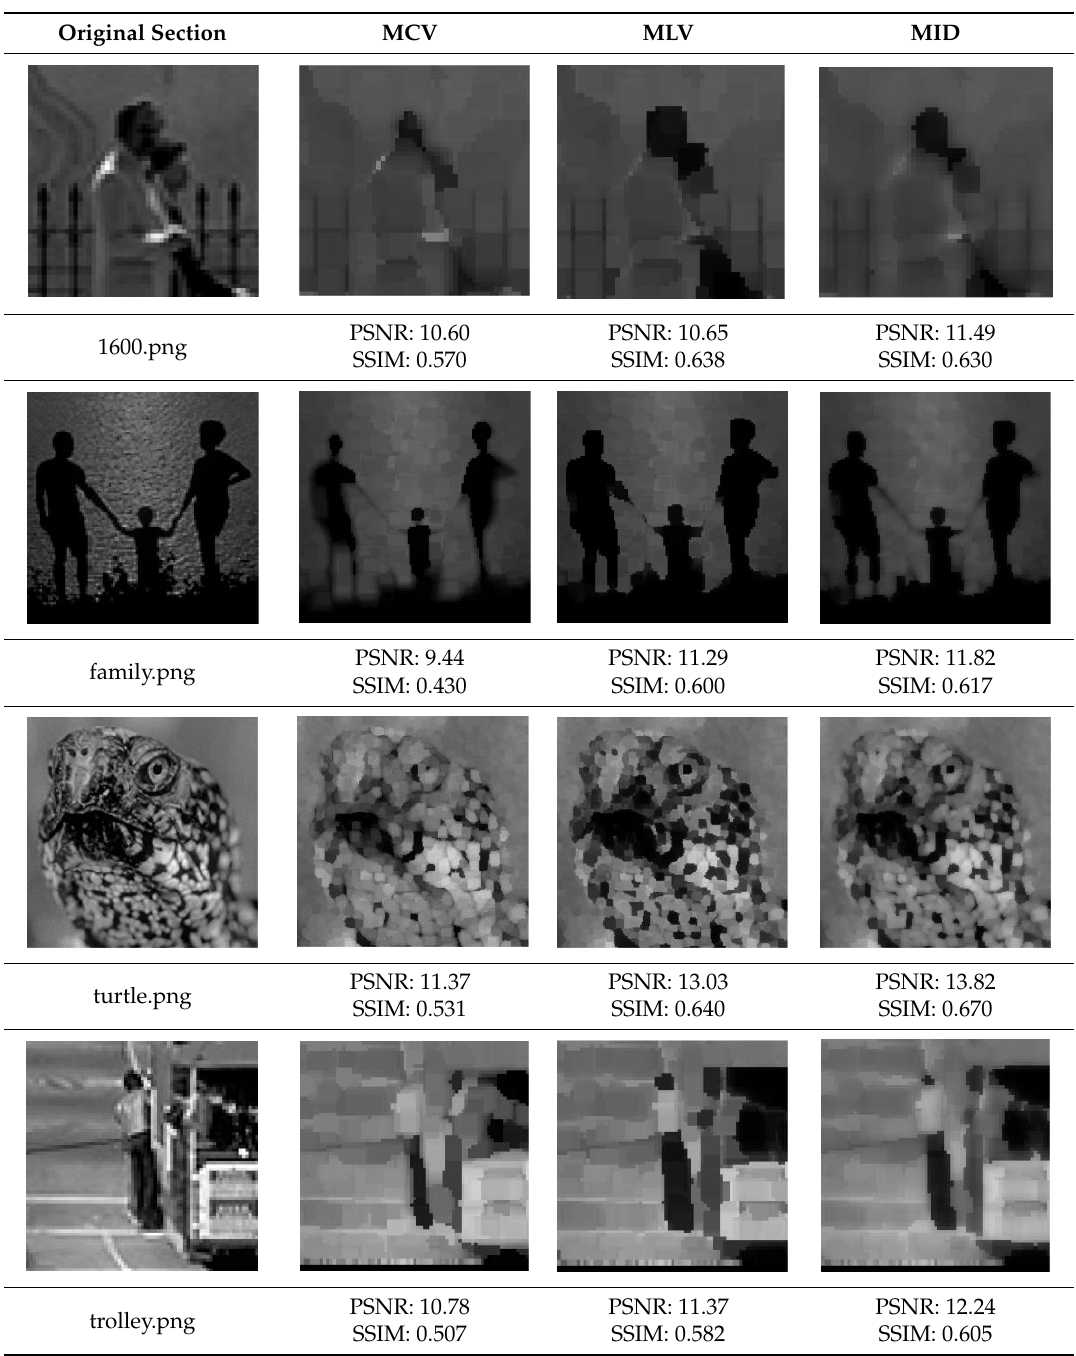
Table 4. Some small cropped image sections from the outputs of filters.